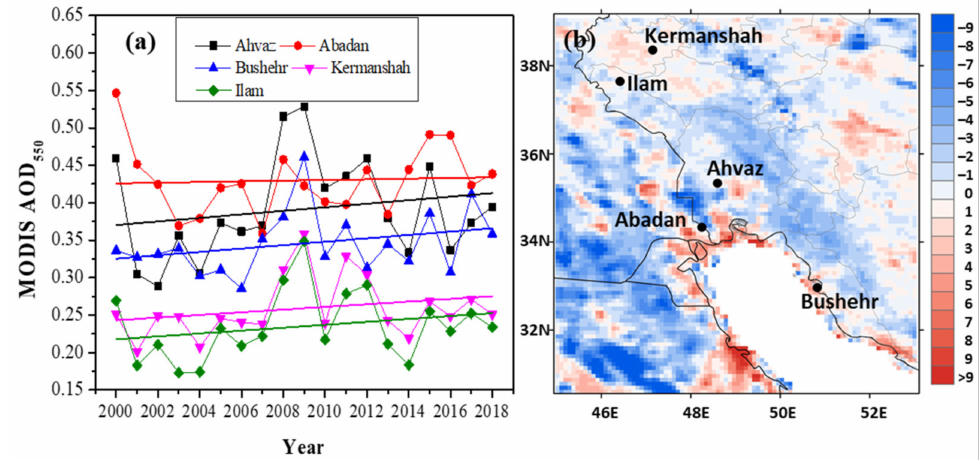
Figure 5. Inter annual variation of the MODIS AOD 550 values (10 km × 10 km) over each station ( a ) and spatial distribution of the MODIS-AOD trends in southwest Iran ( b ) during 2000–2018.